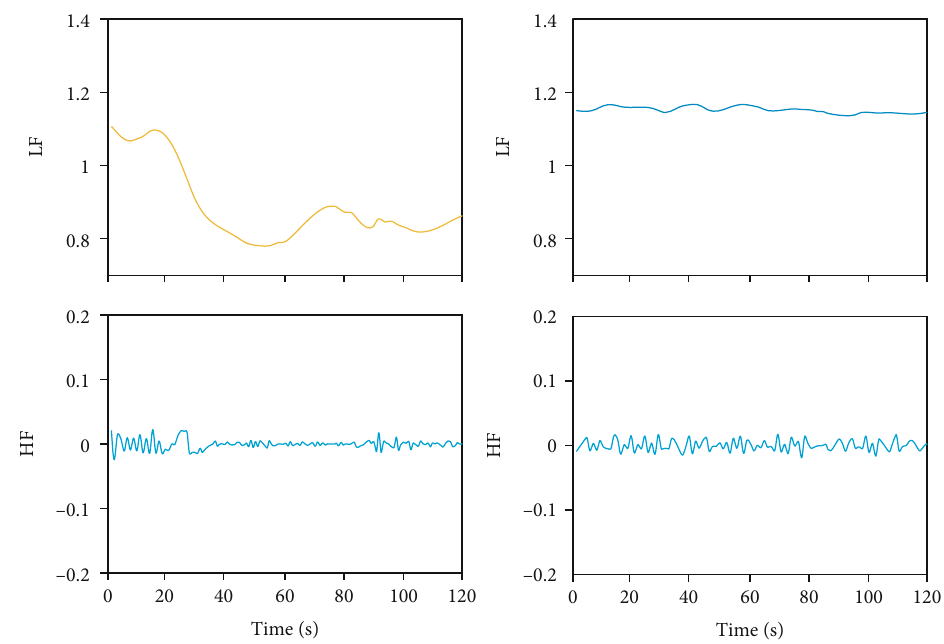
Figure 7: The feature of the signal: under general anesthesia, tracheal intubation stimulation will have an impact on the LF